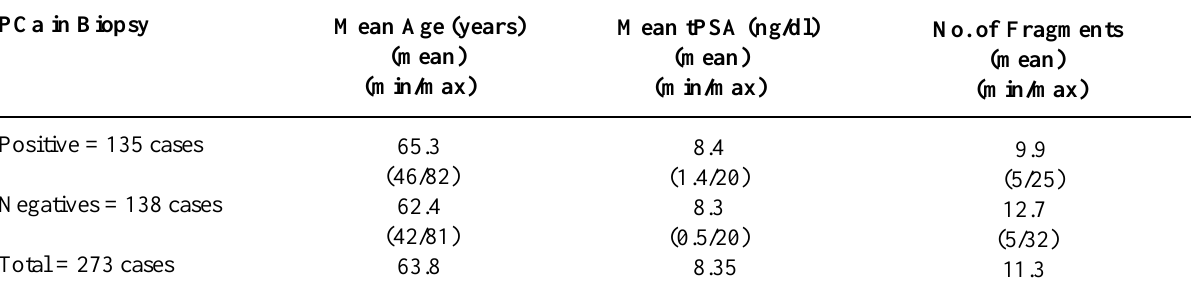
Table 1 – Age, total PSA (tPSA) and number of fragments in biopsies from 273 patients.